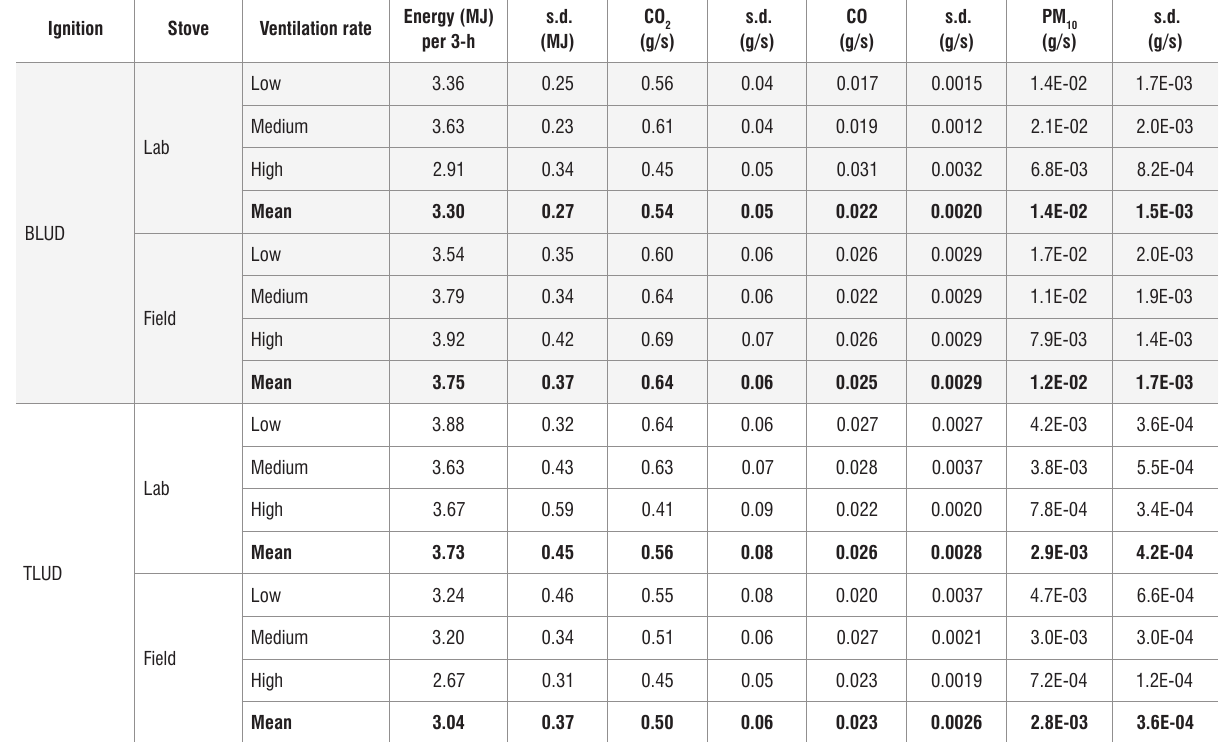
Table 7: Average emission factors over a 3-h combustion sequence for lab and field stoves for the top-lit updraft (TLUD) and bottom-lit updraft (BLUD) ignition methods at low, medium and high ventilation rates ( n =5) Ignition